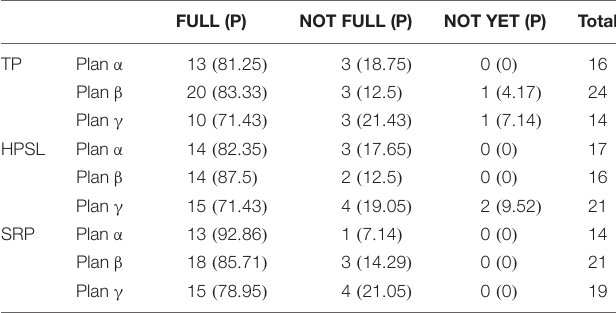
TABLE 4 | Students’ understanding after part 2 of the study